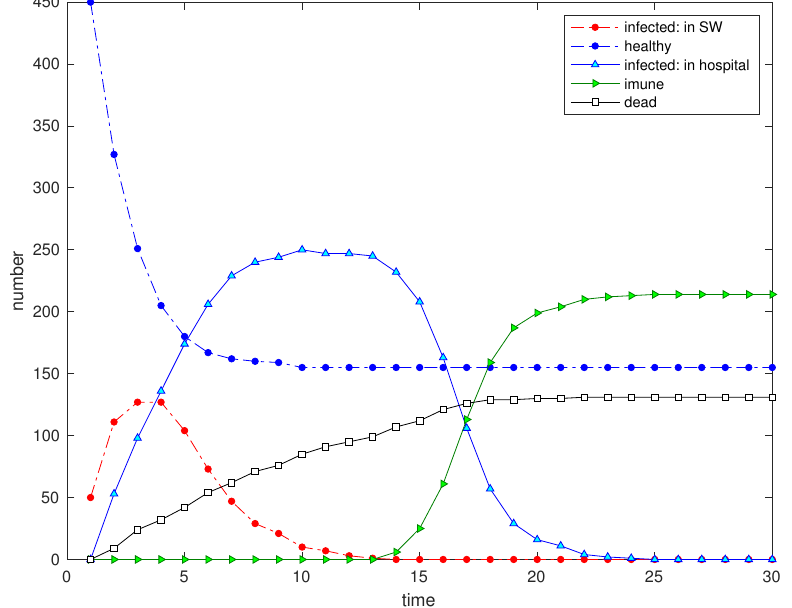
Figure 5. Scenario S 4 : Time evolution of the 5 state variables for D = 0.05 ( N = 500, n i = 50, δ = 0.1, p 1 = 0.1, p 2 = 0.9, p 3 = 0.7, p 4 = 0.05, p 5 = 0.02, α = 2 and N h → ∞ ).